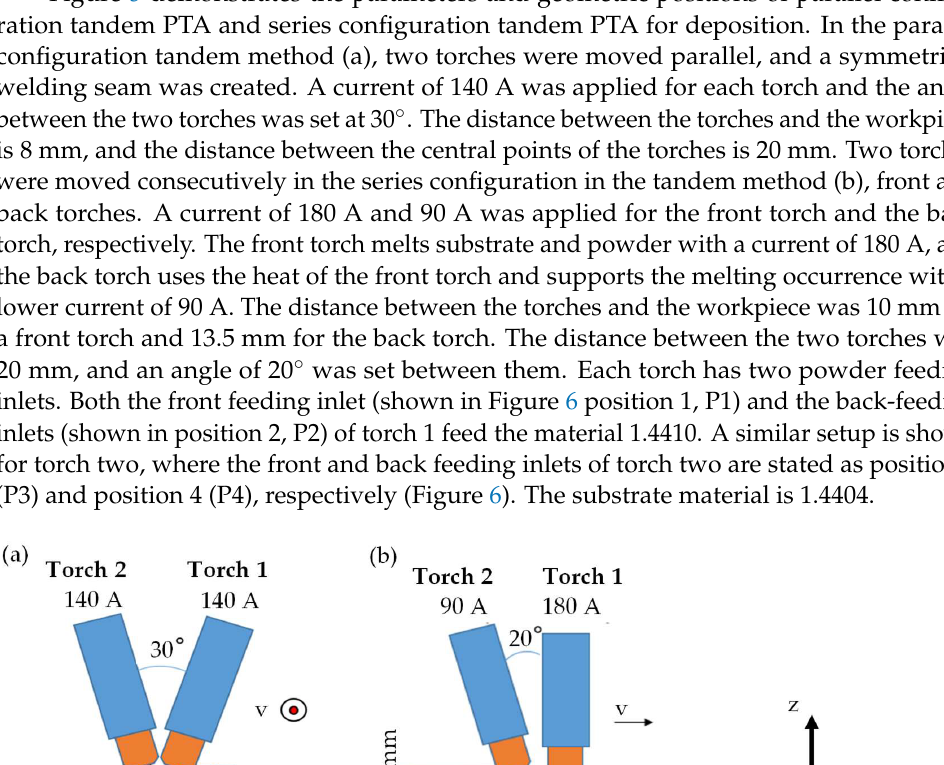
Figure 5. Parameters of the torches for ( a ) parallel configuration tandem PTA, ( b ) series configura- tion tandem PTA.